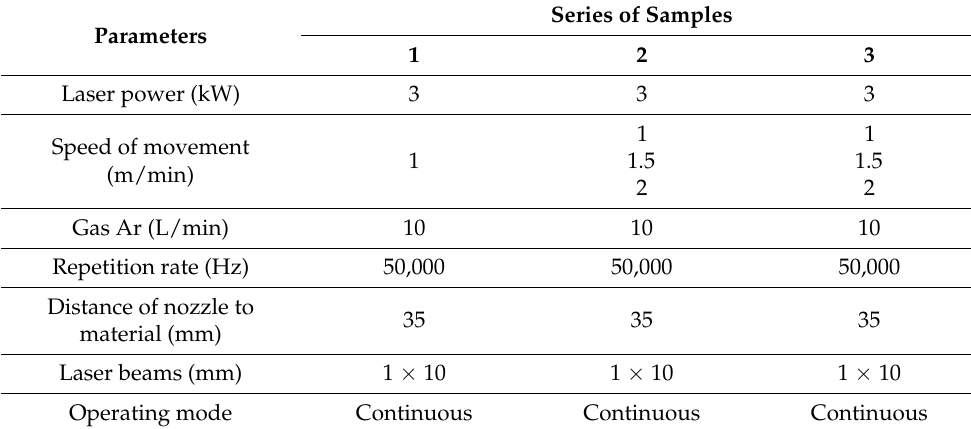
Table 3. Parameters of laser alloying